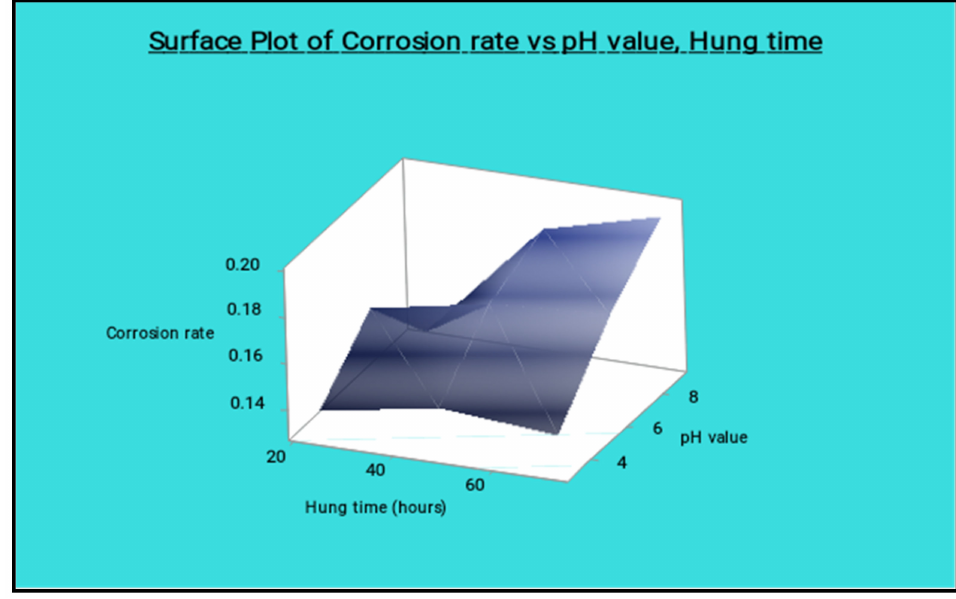
Figure 26. Surface plot of corrosion rate vs. pH value and hang time. The minimum percentage of reinforcement and the slightly increasing hang time gives the lowest corrosion rate, as shown in the surface plot Figure 27. The moderate level of the reinforcement and the lowest level of the hang time present the lowest corrosion